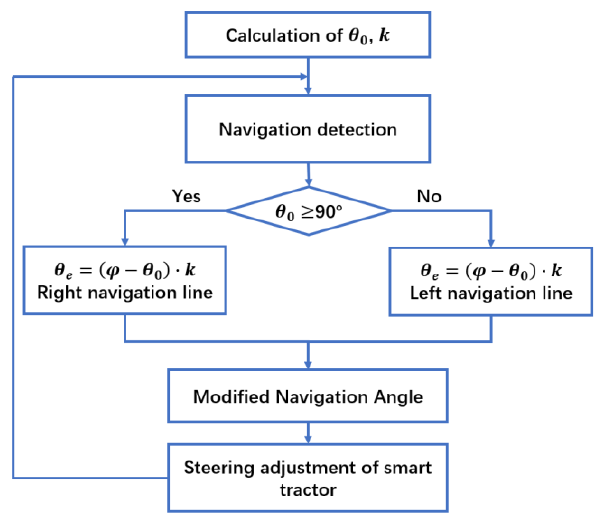
Figure 5. Steering adjustment algorithm flowchart.